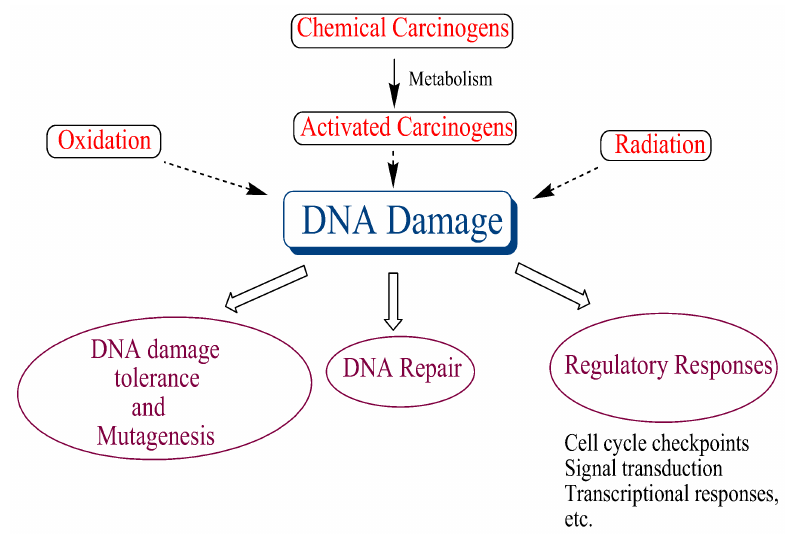
Figure 5. DNA damage plays a central role in many biological processes linked to